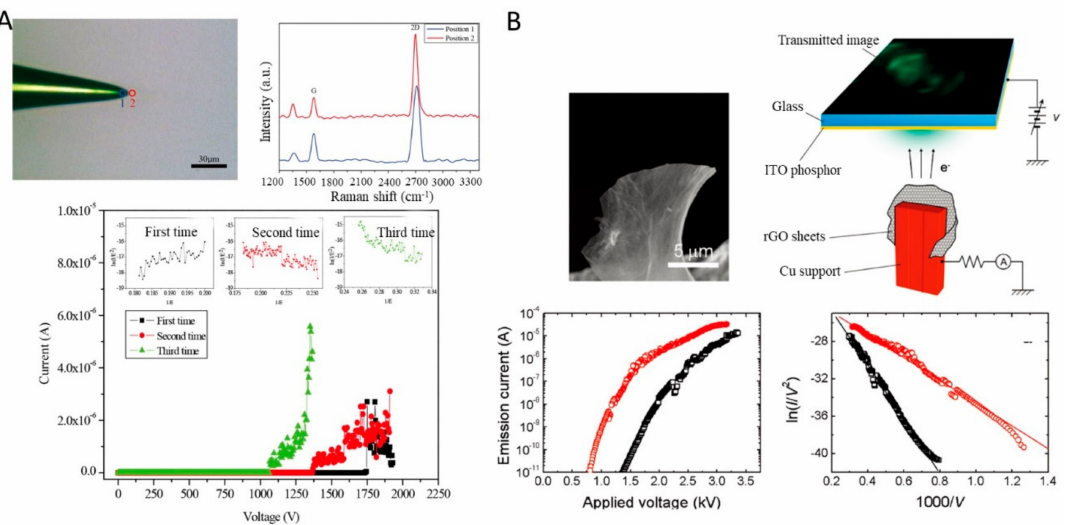
Figure 4. Images of graphene edge field emitters and field emission characteristics. ( A ) Field emission from individual freestanding graphene edge. Reproduced with permission from [70], Copyright Wiley, 2013; ( B ) Field emission from atomically thin edges of reduced graphene oxide. Reproduced with permission from [71], Copyright American Chemical Society (ACS) publications,